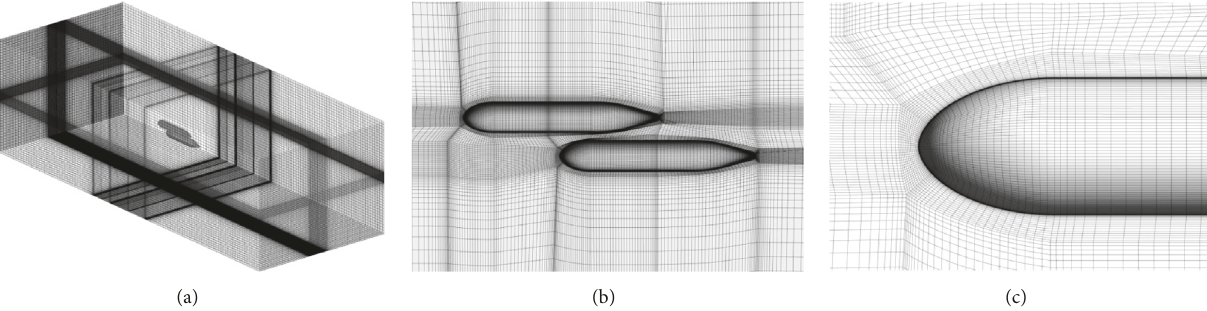
Figure 5: Details of the computation mesh: (a) overview; (b) grids around the vehicle; and (c) prism layer grid elements.